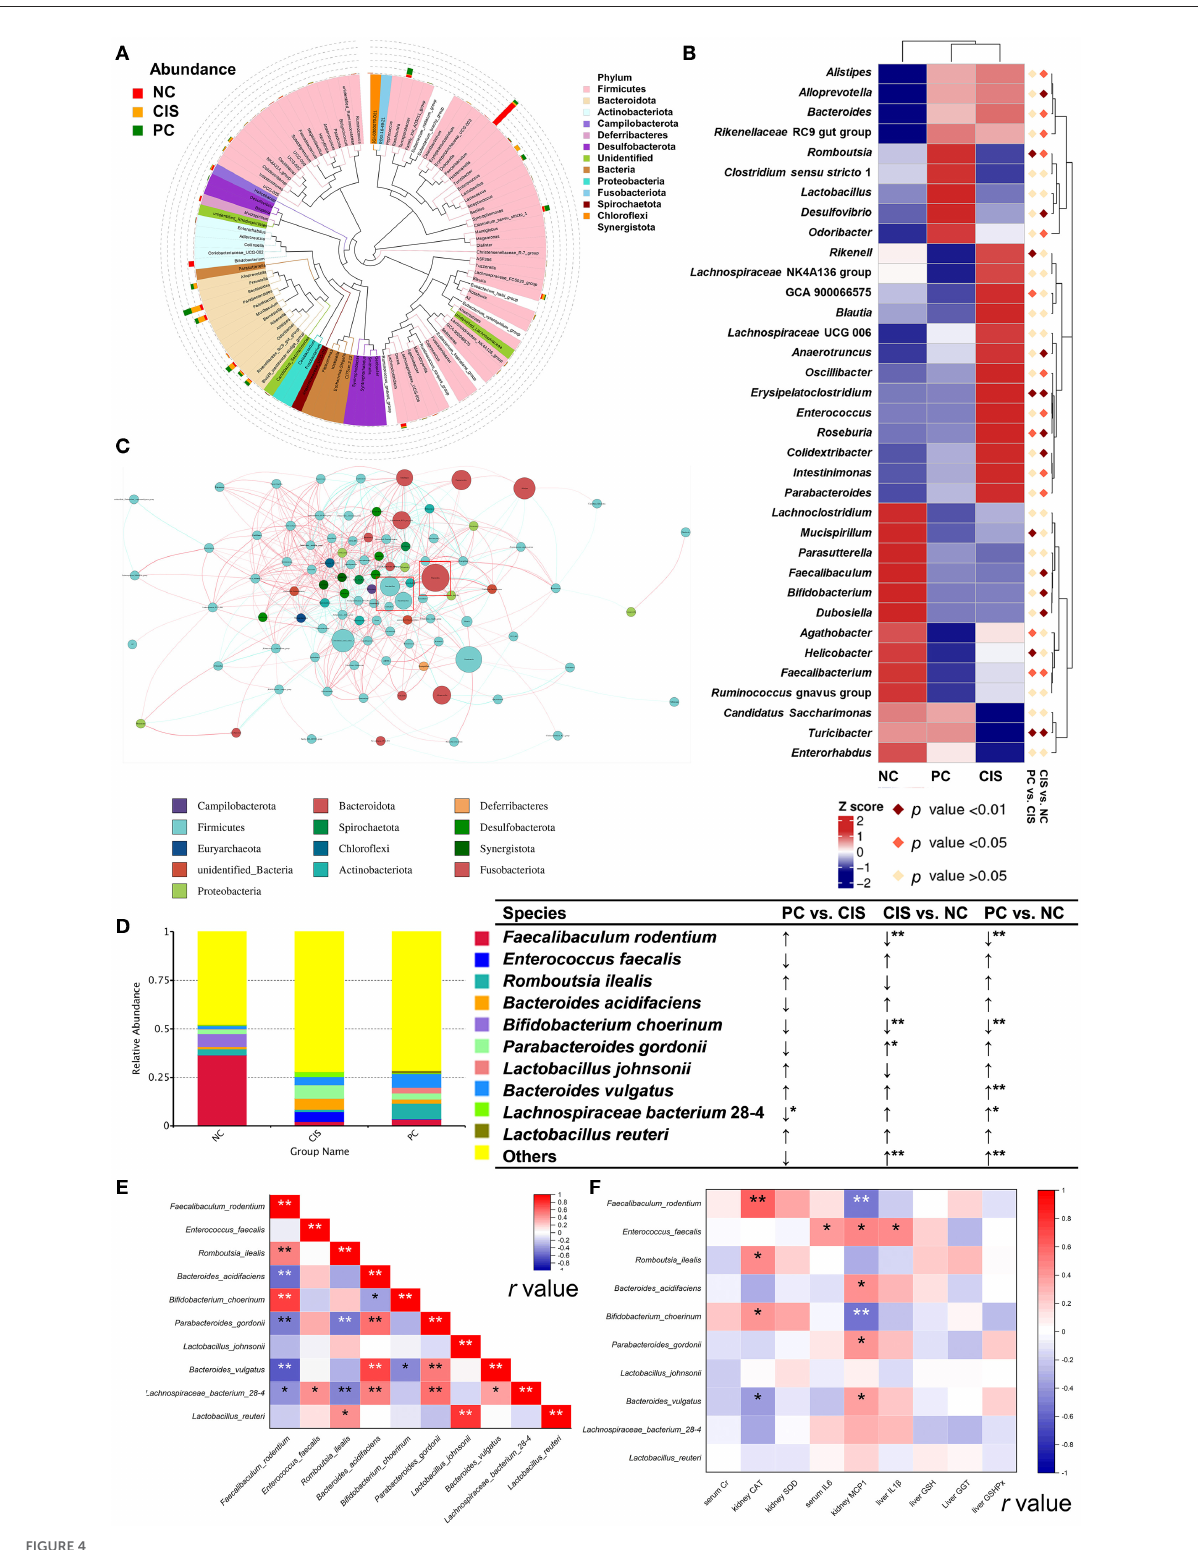
FIGURE4 Gut microbiota analysis at genus level. (A) The top 100 genera evolutionary tree; (B) heatmap of the top 35 genera; (C) genus network analysis in PC group, genera in the red box with blue circle were Lactobacillus and Faecalibaculum , and genus in the red box with a red circle was Bacteroides ; (D) relative abundance of the top 10 species; (E) Spearman correlation analysis among the top 10 species; (F) Spearman correlation analysis between abundances of species and levels of biochemical parameters. n = 10 for the PC and NC groups, n = 9 for the CIS group (one mouse in the CIS group died before collecting feces); NC, normal control; CIS, cisplatin; PC, cisplatin with C-phycocyanin; ↑ , upregulation; ↓ , downregulation; *, p < 0.05; **, p <